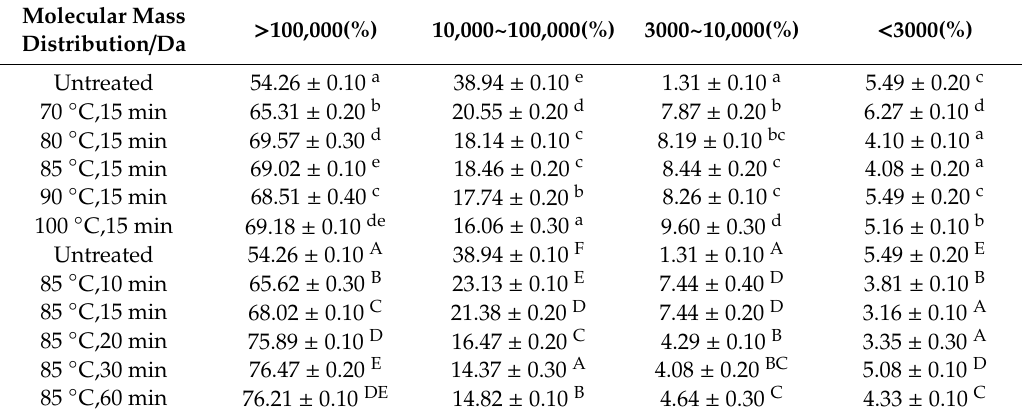
Table 2. Protein molecular distribution as a function of digestion SPIs at di ff erent heat treatment. Molecular Mass